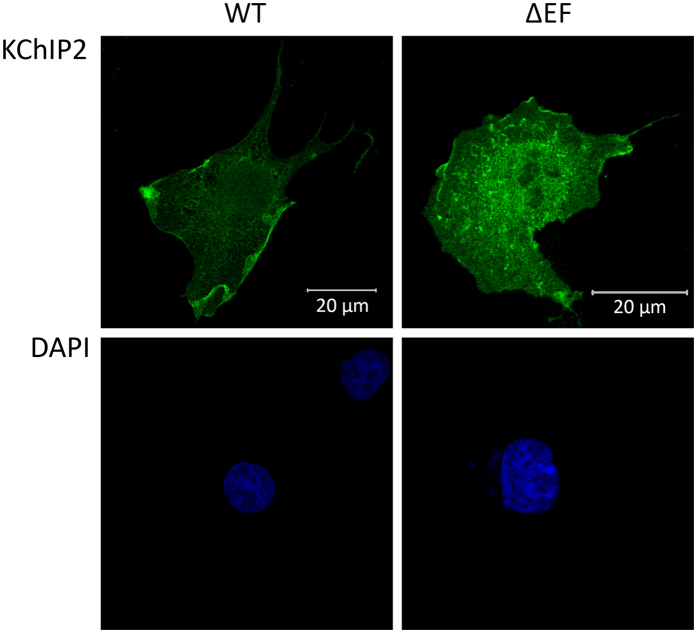
Regular KChIP2 (WT) and KChIP2-∆EF (∆EF) expression and localization in COS-1 cells.COS-1 cells transfected with WT KChIP2 and KChIP2-∆EF and treated with 10 μM ionomycin for 40 min. Pictures showing representative cells stained using a KChIP2 antibody (green). The nucleus is stained blue using DAPI. Both KChIP2 and KChIP2-∆EF are present in the nucleus.